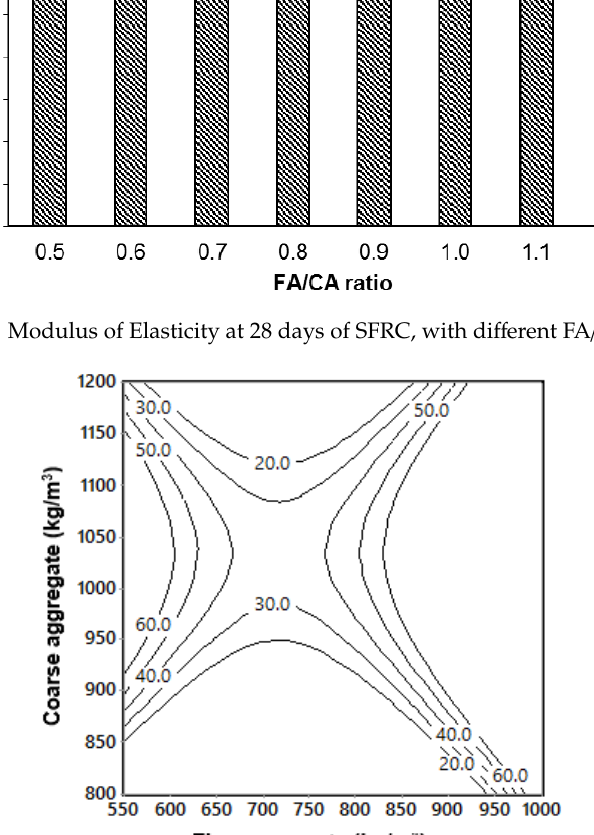
Figure 10. Modulus of Elasticity at 28 days of SFRC, with different FA/CA ratios.